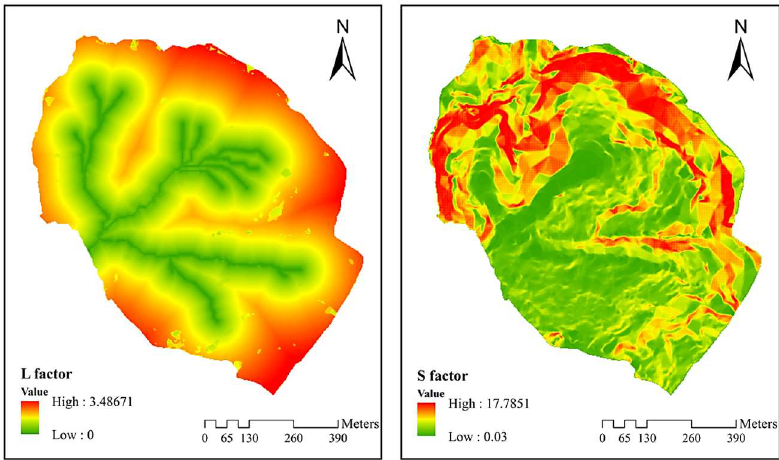
Figure 4. The L and S factors in RUSLE.